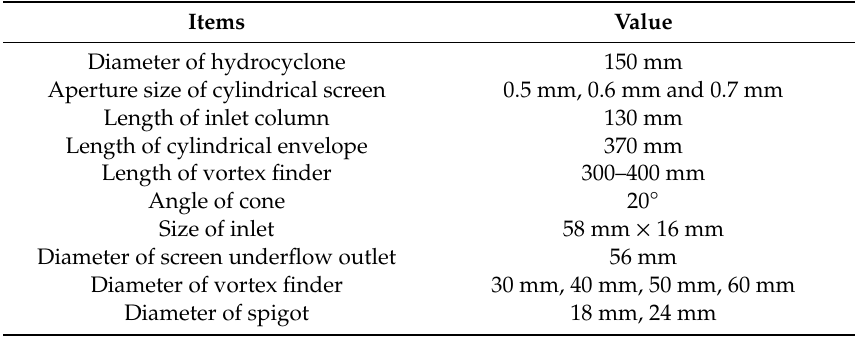
Figure 2. P ilot ‐ scale experiment rig for TPHS. Figure 2. Pilot-scale experiment rig for TPHS. Table 1. Structures of TPHS in pilot-scale Table 1. Structures of TPHS in pilot ‐ scale experiment.